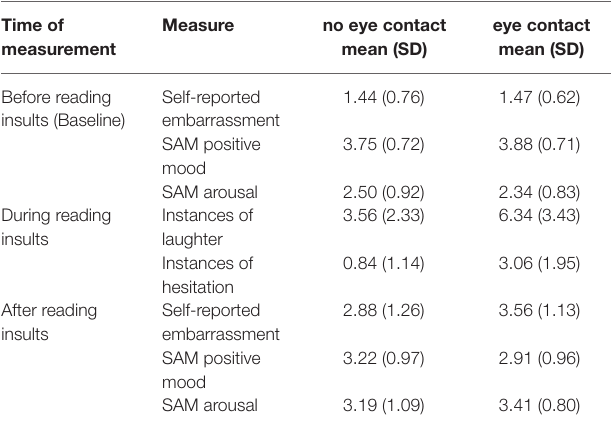
TABLE 1 | Mean and SD for observational and self-report outcome measures by condition.